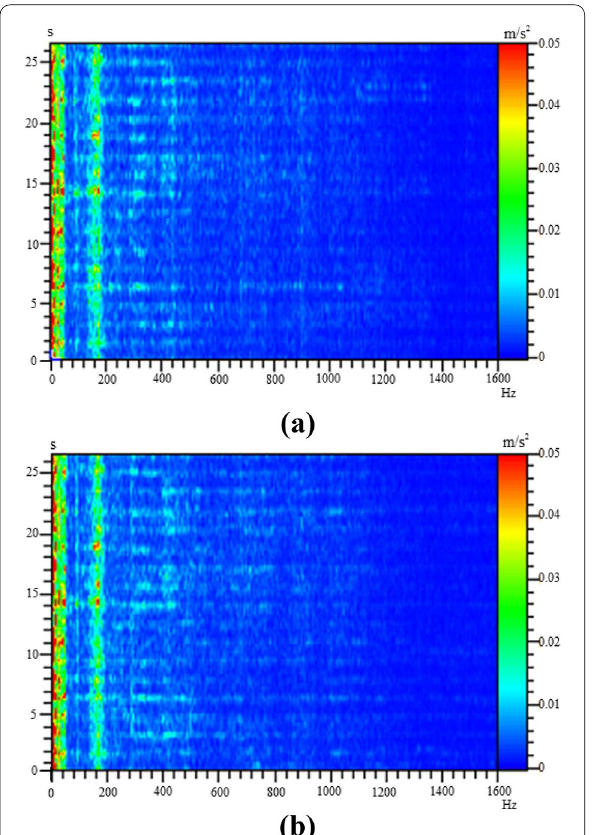
Figure 9 Comparison between a calculated and b measured values of the target point